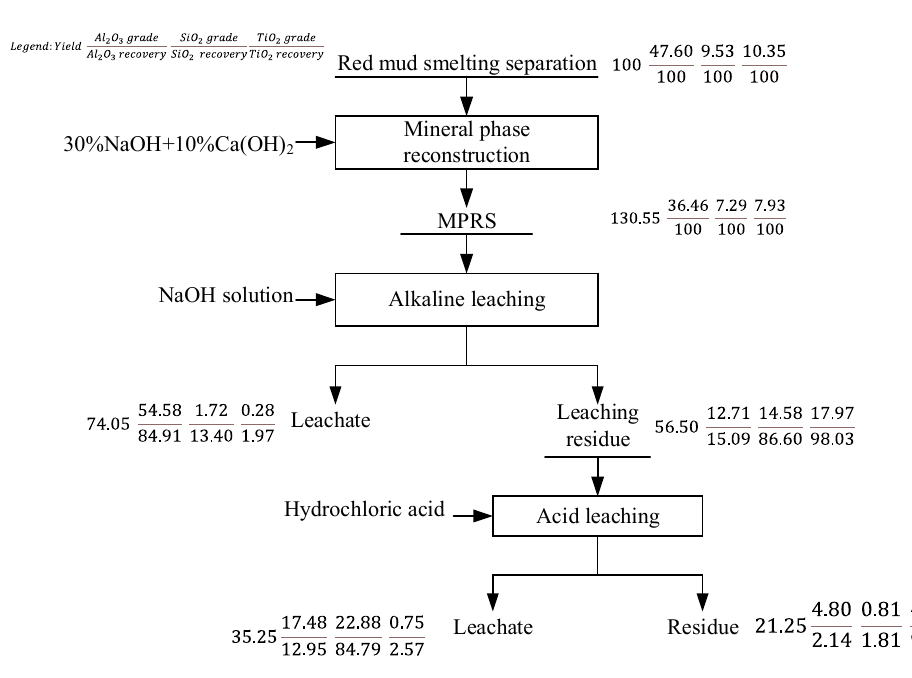
Figure 13. Elements balance in the full sheet.